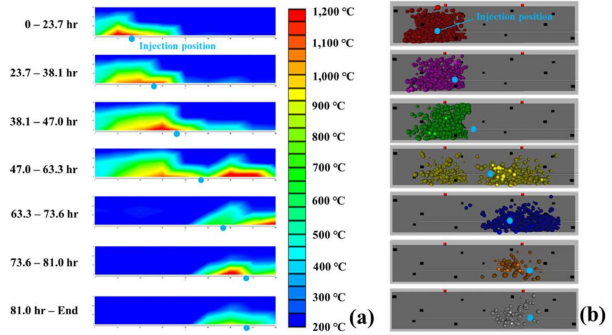
Figure 8. Comparison between results of temperature and AE monitoring. ( a ) Temperature distribution; ( b ) AE source location.